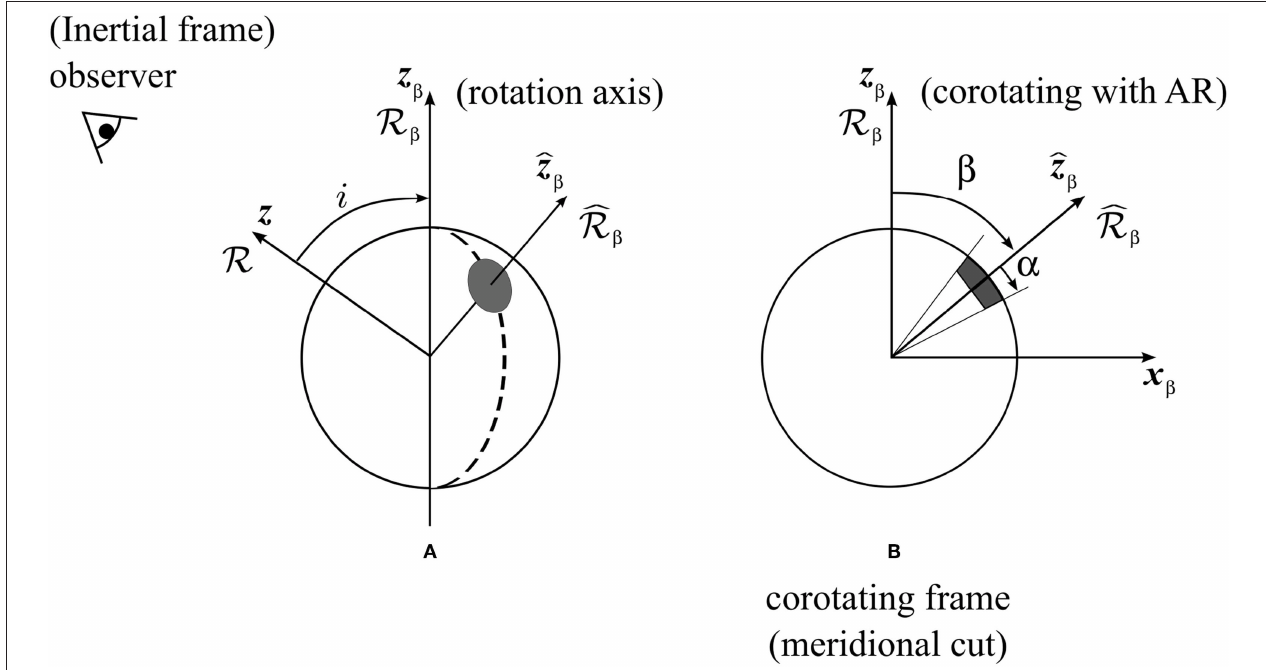
FIGURE 1 | Reference frames and angles of the problem. Arrows show the polar axes of the coordinate systems R , R β , and the observer. The rotation axis of the star is inclined by an angle i with respect to the line of sight. Both frames R β and at a constant angular velocity (cid:127) β . The polar axis of R β is aligned with the rotation axis of the star. In R β the active region has a colatitude β and in